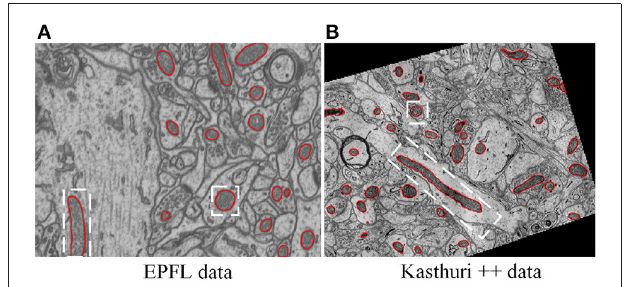
FIGURE 1 | Illustration of typical EM images, in which mitochondria show varied shapes. (A) The EPFL data (Lucchi et al., 2013) were taken from CA1 hippocampus region of a mouse brain, (B) the Kasthuri++ data (Casser et al., 2020) were taken from mouse cortex. The red contours represent the corresponding ground-truth segmentation.